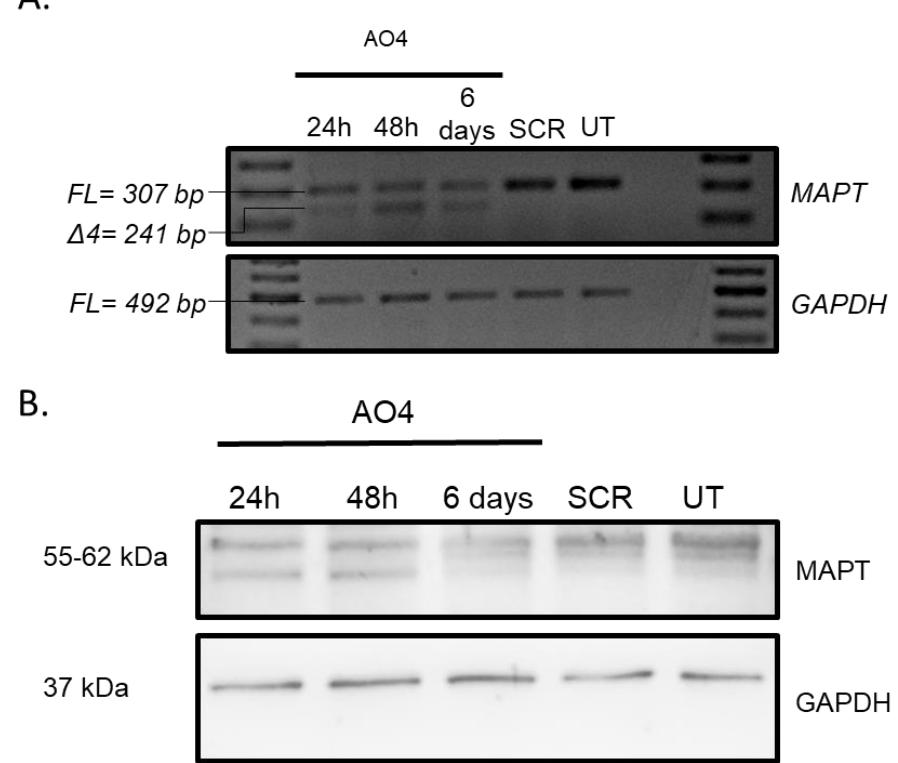
Figure 5. ( A ) Representative RT-PCR products of the MAPT transcripts from SH-SY5Y cells after treatment with an AO4 50 nM concentration and incubation of AO for 24 h, 48 h, and six days. RNA from AO4-treated samples was analysed using primer set 2. ( B ) Representative protein products of the MAPT and GAPDH transcripts from SH-SY5Y cells after treatment with AO4 at 50 nM concentrations and incubation of AO for 24 h, 48 h, and six days. RT-PCR products of the MAPT transcripts and protein products of the MAPT and GAPDH transcripts from SH-SY5Y cells after treatment with SCR at 50 nM concentrations and incubation of SCR for six days. FL, full-length; UT, untreated; SCR, scrambled sequence. GAPDH was used as a loading control. The gel images were cropped to highlight the MAPT -specific products and the corresponding house-keeping gene control GAPDH. The original images are shown in Figure S7 (Supplementary Material).